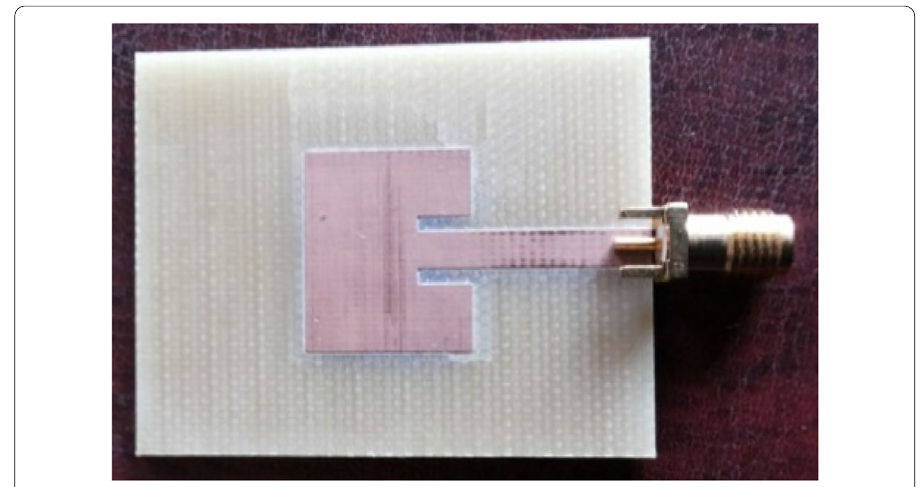
Fig. 2 Fabricated reference patch antenna